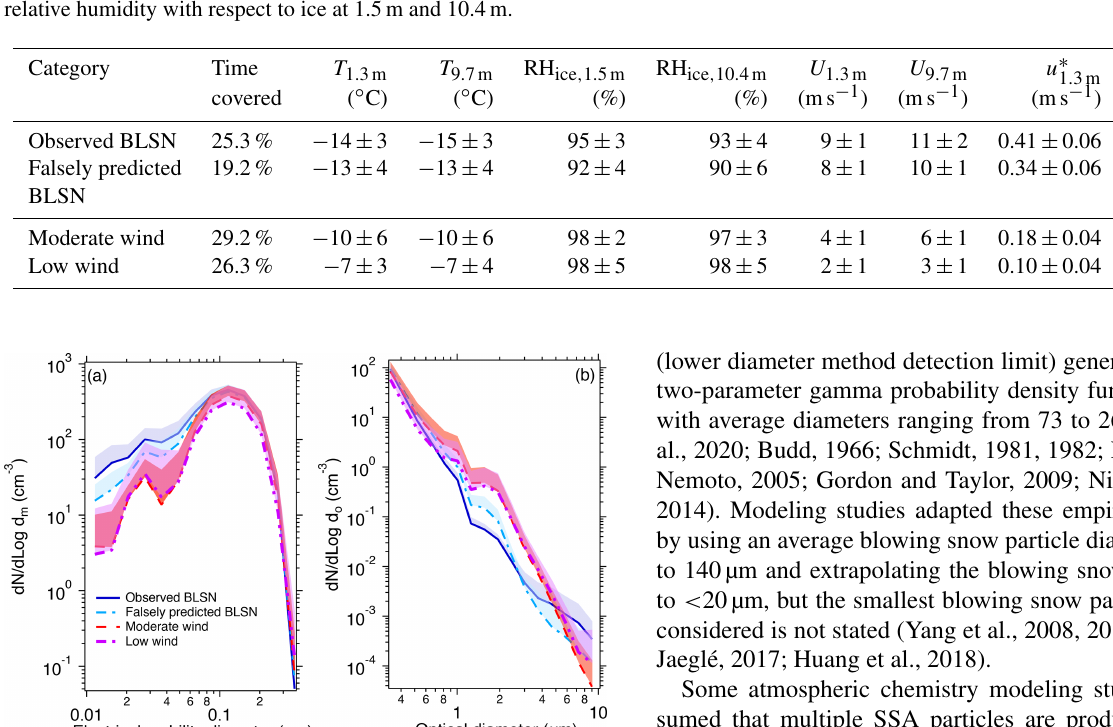
Table 2. Meteorological conditions during observed BLSN, falsely predicted BLSN, moderate wind speed, and low wind speed periods. T , U , and u ∗ (average ± 1 σ ) are air temperature, wind speed, and friction velocity at 1.3 and 9.7m above the ground, respectively. RH ice is the relative humidity with respect to ice at 1.5m and 10.4m.